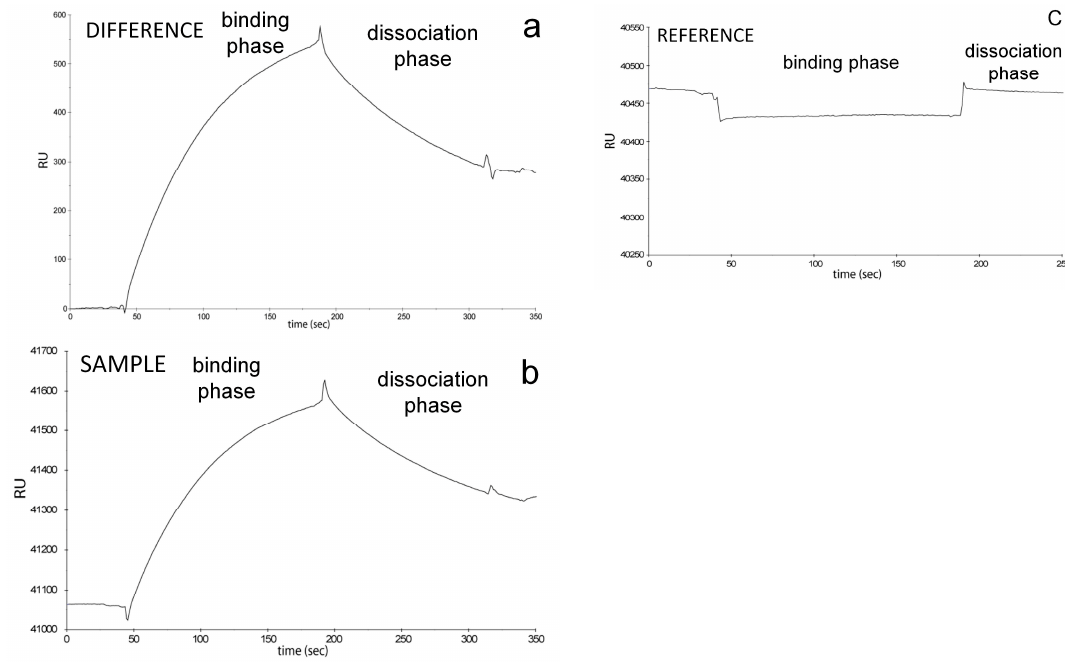
Figure 2. Individual components of an SPR sensorgram. ( a ) The SPR difference is obtained by subtracting a sensorgram obtained in a sample cell ( b ) with sensorgram obtained in a reference cell ( c ). See text for details. Reproduced from [28].